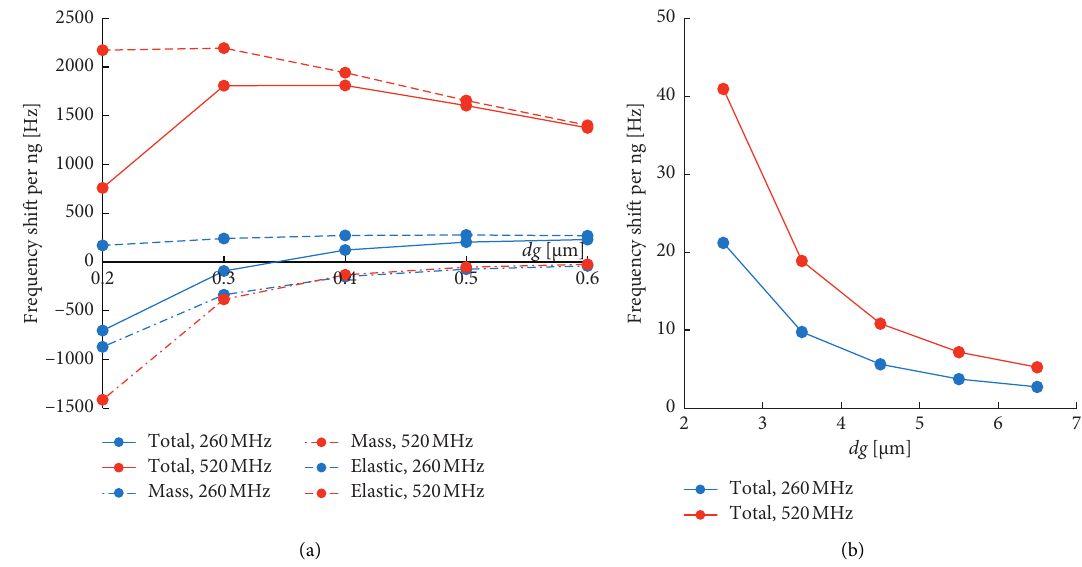
Figure 5: Sensitivity vs. geometric mass mean diameter d σ g � 2.2 and (b) PM10 with d g � 2.5 ∼ 6.5 μ m and σ g � 1.6.